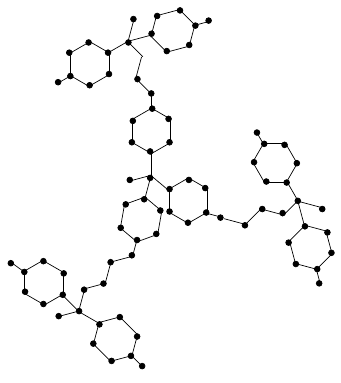
Figure 15. The graph of polyther dendrimer PD 3 [ 1 ]